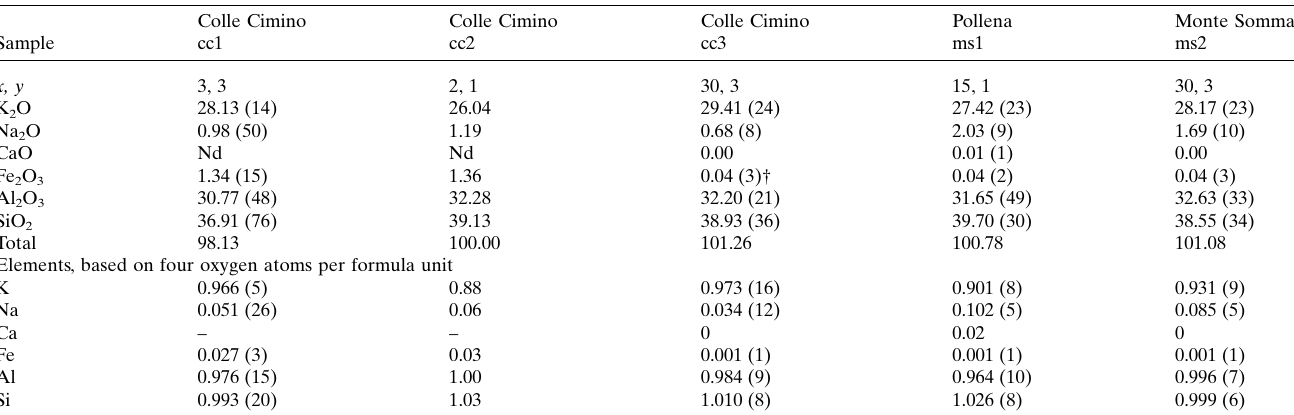
Table 2 Results of elemental analyses obtained for several crystals of kaliophilite from Colle Cimino and Monte Somma. x represents the number of points analyzed and used for averaging and y represents the number of analyzed grains. ‘Nd’ stands for not detected. Analyses of sample cc2 were performed on nanometric fragments using a transmission electron microscope and have a dispersion not comparable with other measurements. Colle Cimino Colle Cimino Sample cc1 cc2